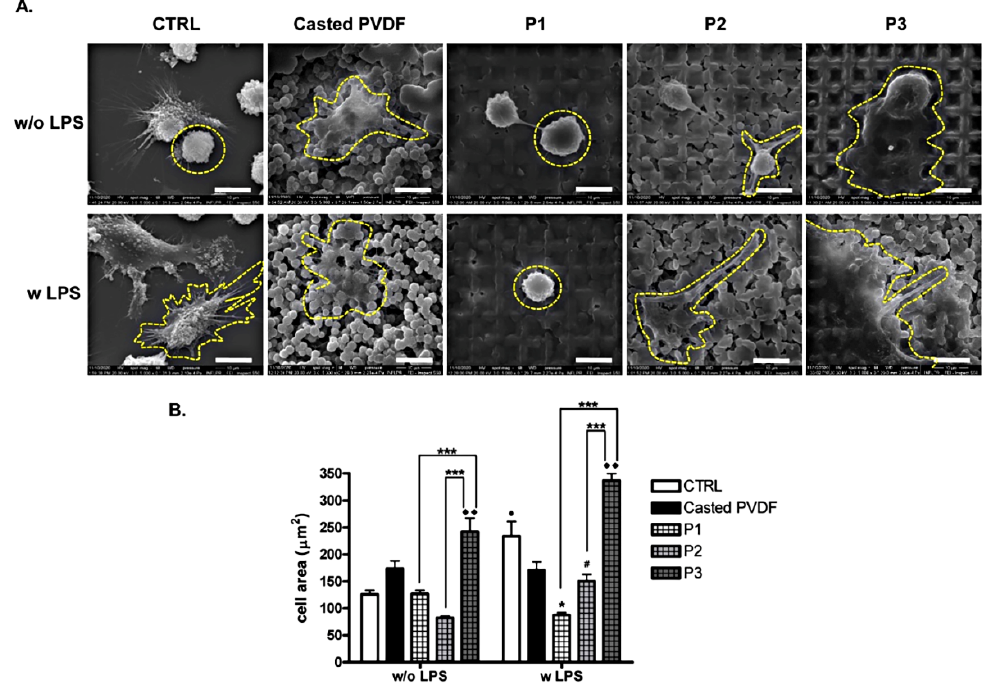
Figure 7. ( A ) Representative images of THP-1 derived macrophage cells morphology on surface materials seen by SEM microscopy at 5000× magnification (Inspect S Electron Scanning Microscope). Scale bar is 10 µm.; ( B ). Quantification of cell area (µm 2 ) • p < 0.05 vs CTRL w/o LPS, * p < 0.05 vs P1 w/o LPS, # p < 0.05 vs P2 w/o LPS, p < 0.01 vs P3 w/o LPS, *** p < 0.001 P1 vs P3 and P2 vs P3 in inflammatory and non-inflammatory conditions.